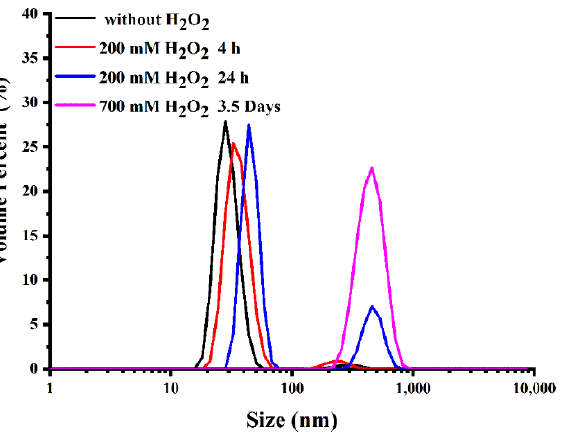
Figure 2. Size distribution of TTCI NPs after treatment with various H 2 O 2 concentrations for differ- ent times. different